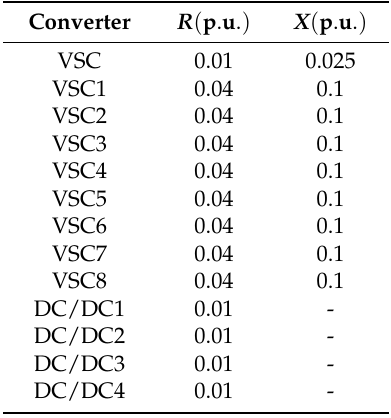
Table A1. Converter data of the test system.